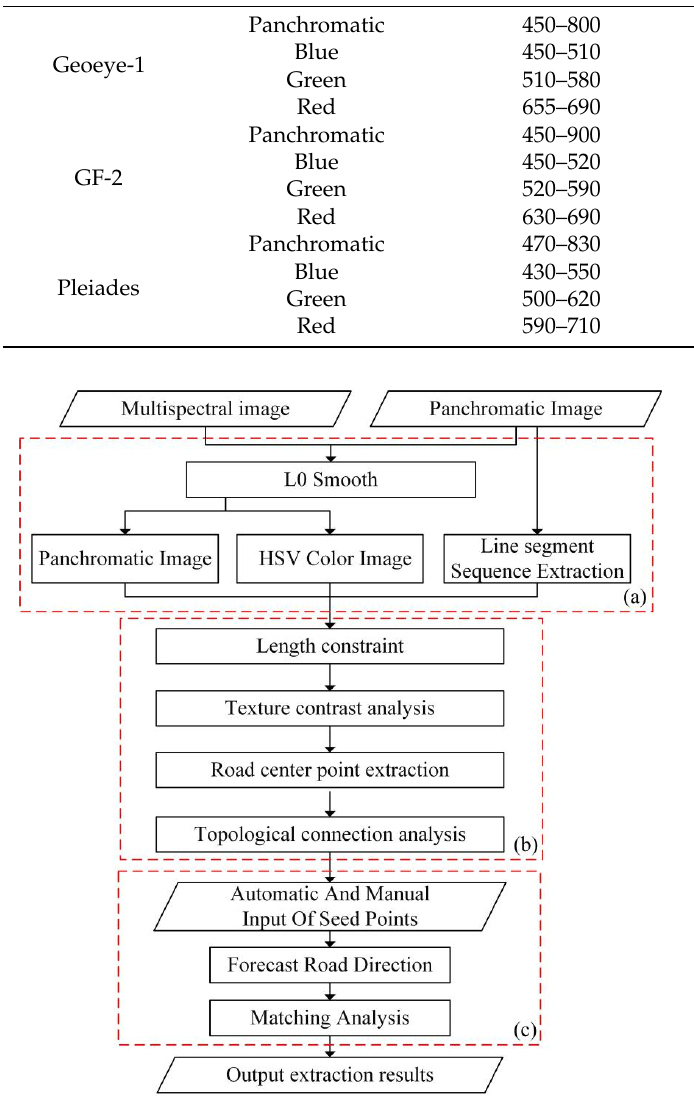
Figure 1. Method flowchart.